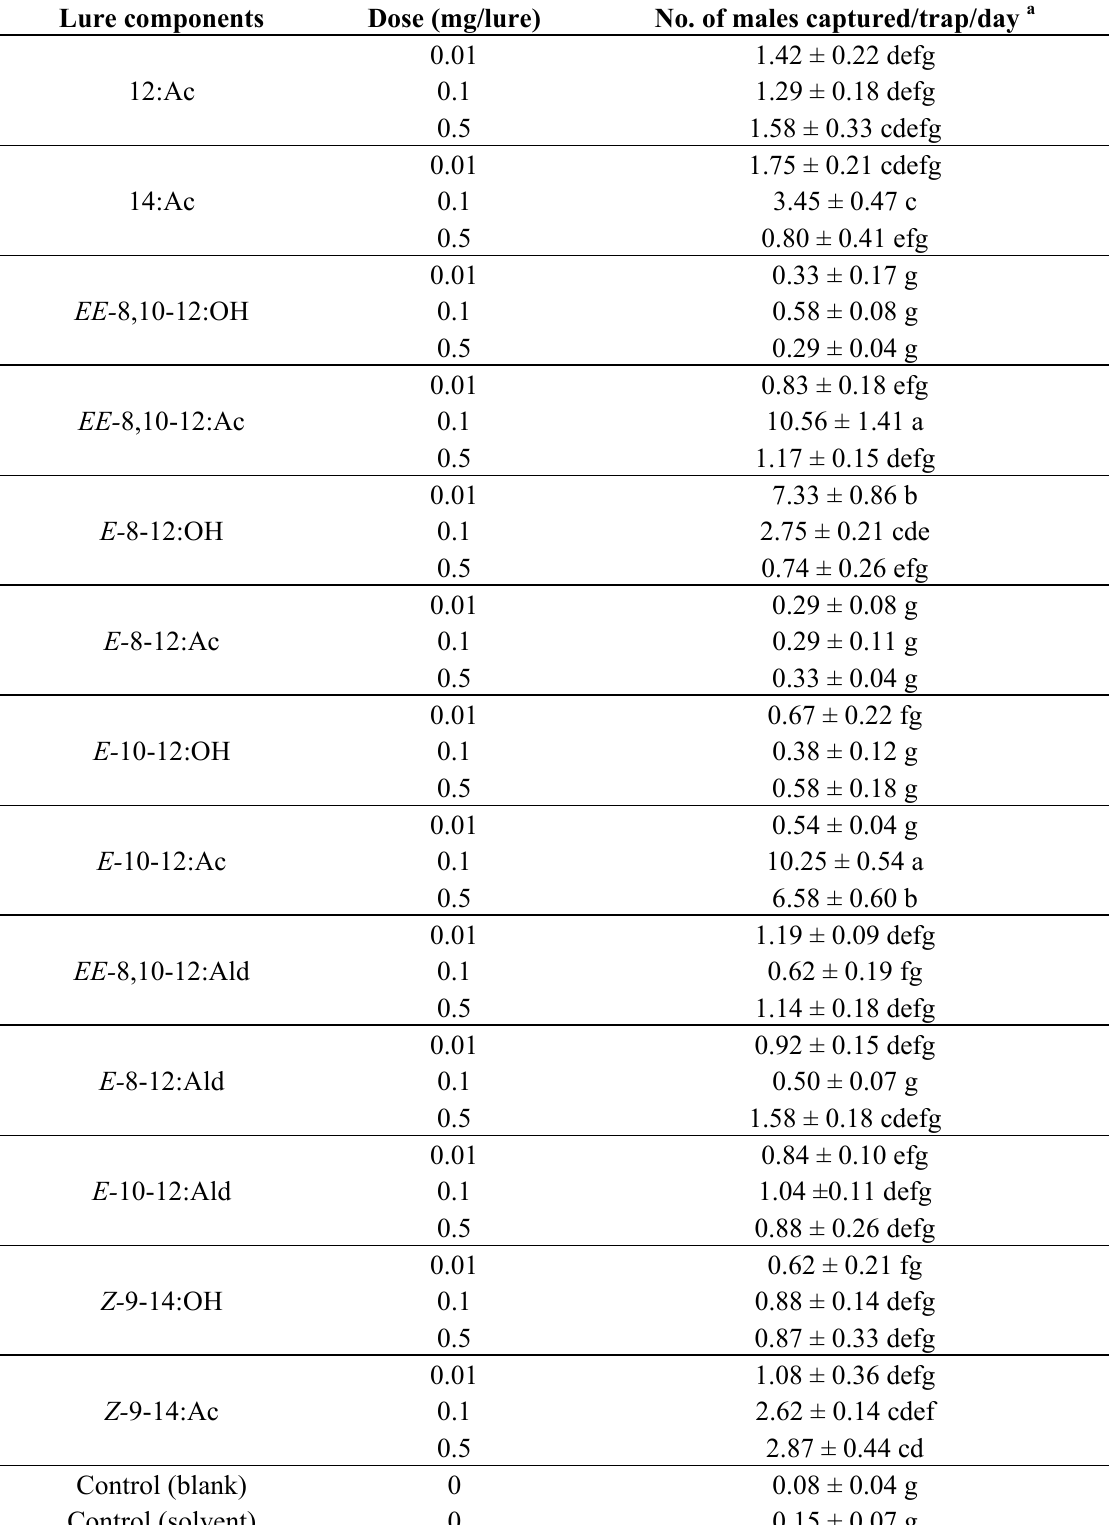
Table 1. Mean (±SE) numbers of L. glycinivorella males captured in traps baited with different synthetic compounds at three doses in a soybean field in Harbin, China, from 30 July to 6 August